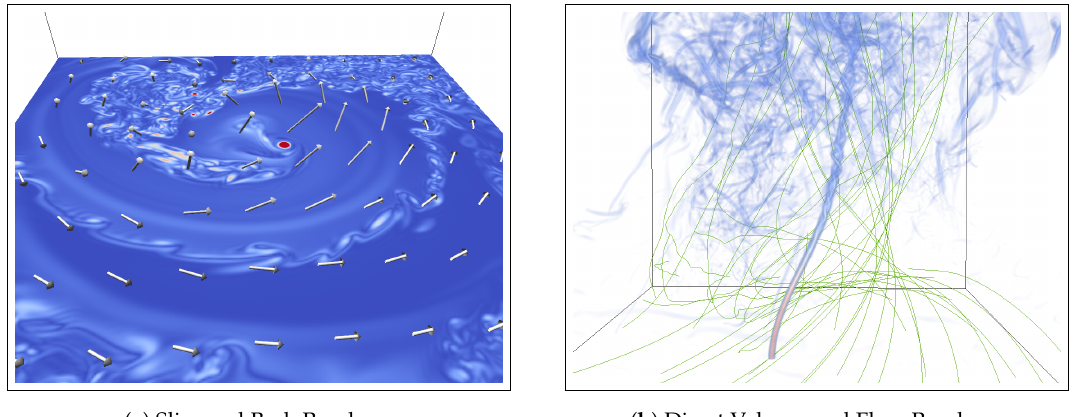
Figure 4. Showcase of four renderers. ( a ) A tomography style slice in perpendicular to the vortex core of a tornado and a group of barbs showing the wind direction. The slice is of variable cloud liquid water (qcloud), and the barbs are of the wind velocity. ( b ) A volume rendering of the vorticity magnitude showing the vortex core of a tornado and a group of flow lines (in green) of velocity showing trajectories of particles being advected by the